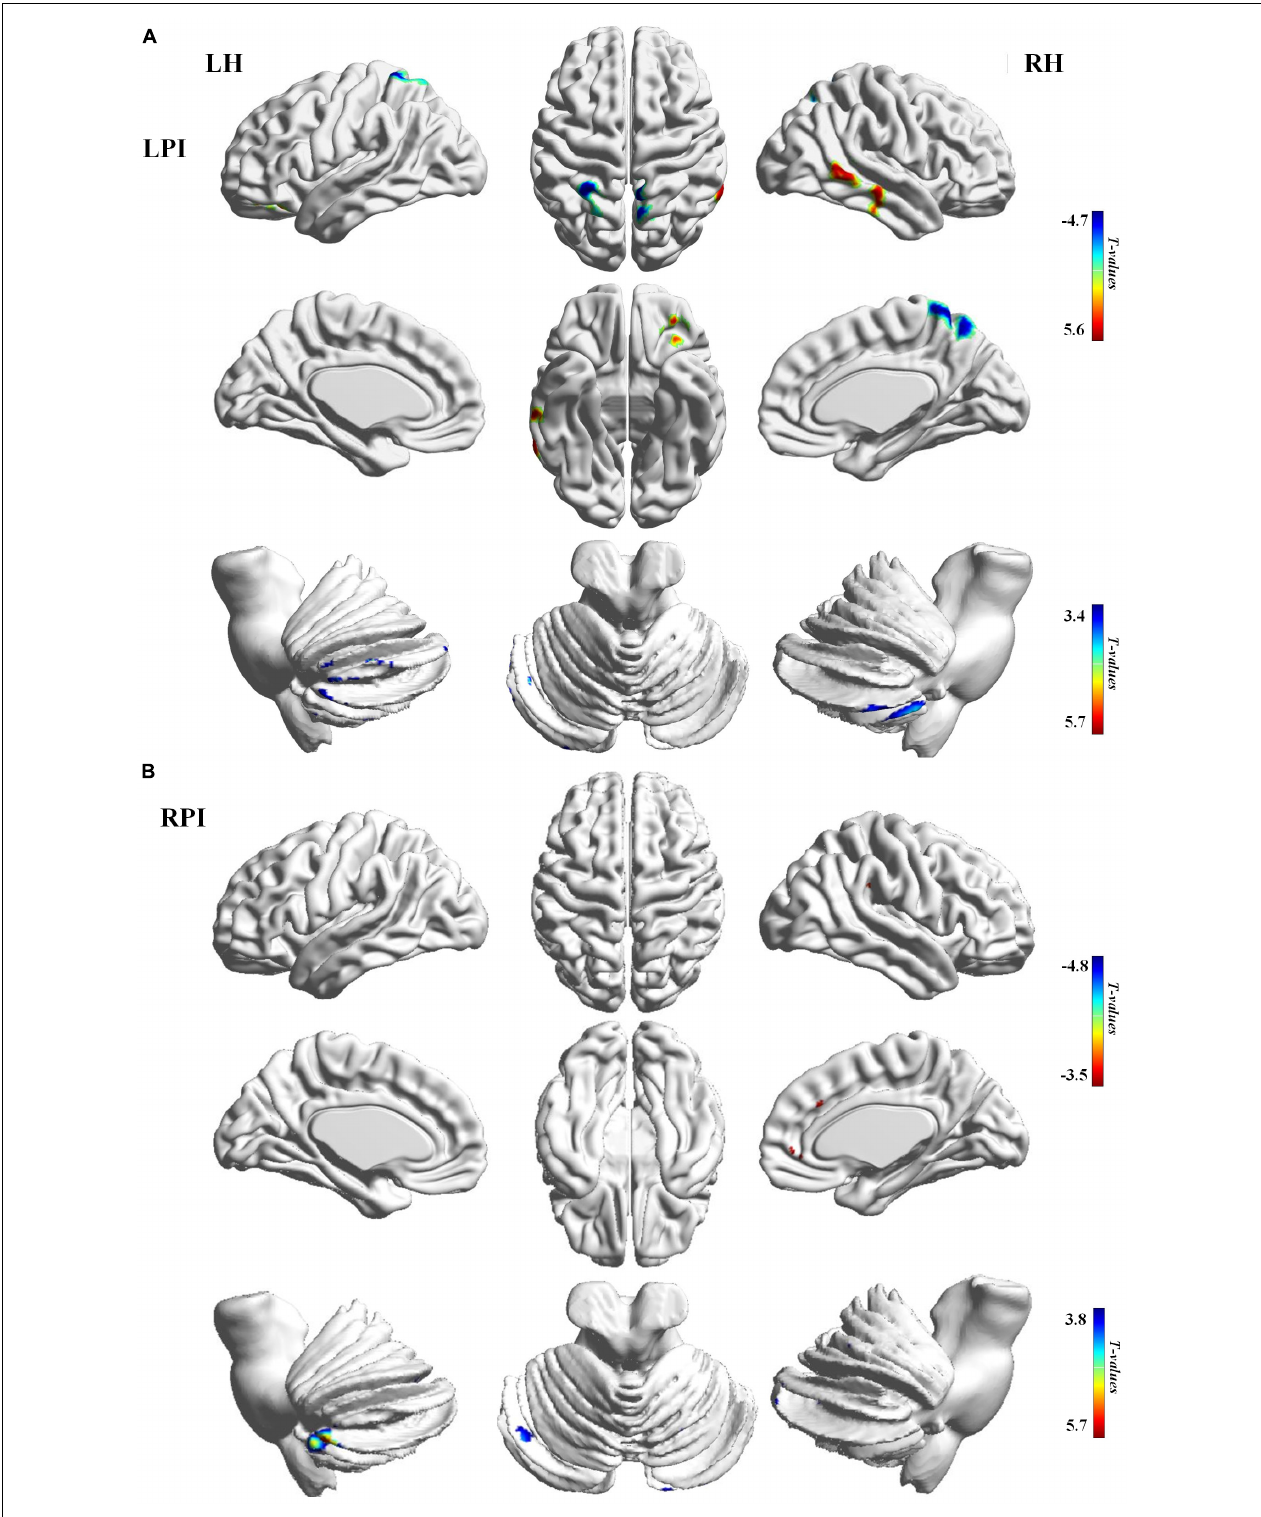
FIGURE 2 | CBF differences between the baseline subgroups of the PI and NC groups. (A) Voxel-base analysis showed brain regions with significant CBF alterations in the baseline stage of the LPI group. (B) Voxel-base analysis showed brain regions with significant CBF alterations in the baseline stage of the RPI group. The color bar indicated the t scores. LH, left hemisphere; RH, right hemisphere; LPI, left pontine infarction; RPI, right pontine infarction.